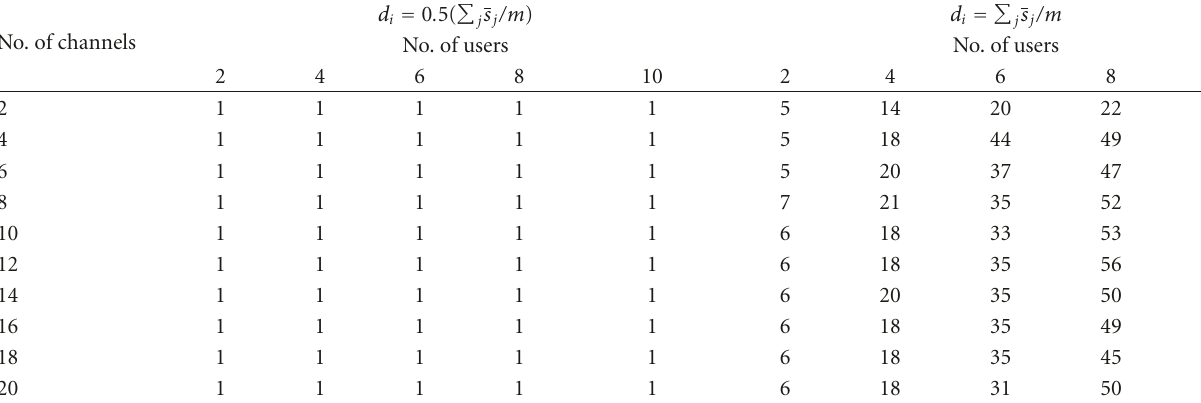
Table 2: Comparisons of CPU time (seconds) required to achieve the budget allocation where the competitive equilibrium satisfies power